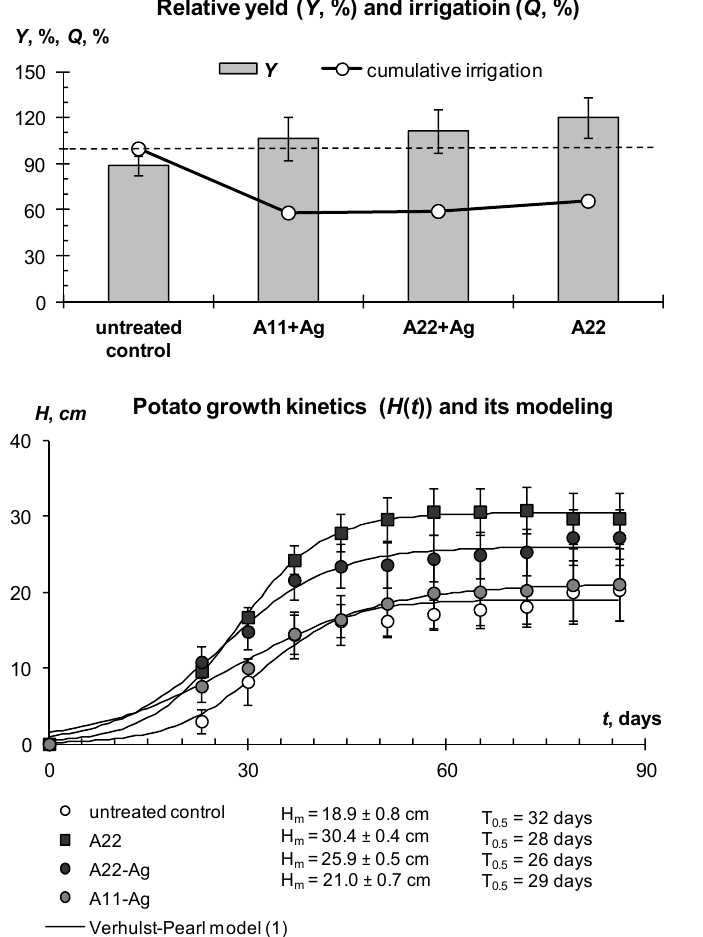
Figure 15. Yield and growth the Red Scarlett potato variety under the influence of irrigation and gel-forming soil conditioners (Moscow region, Retisol, drip irrigation, 2020). The dotted line (100%) is the potential yield of 30 t/ha.